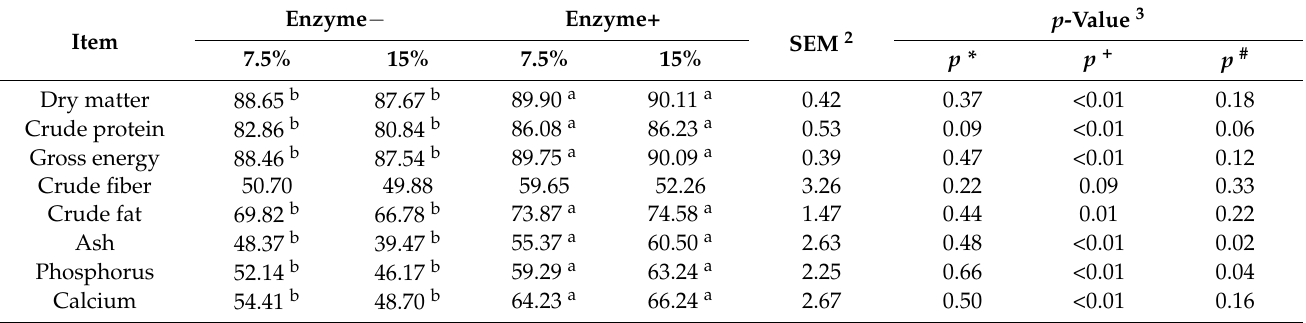
Table 5. Effects of different moisture contents (adding 7.5 vs. 15% water) and enzyme additions (adding 4 kg/t α -amylase or not) to extruded corn on the apparent total tract digestibility in weaning piglets 1